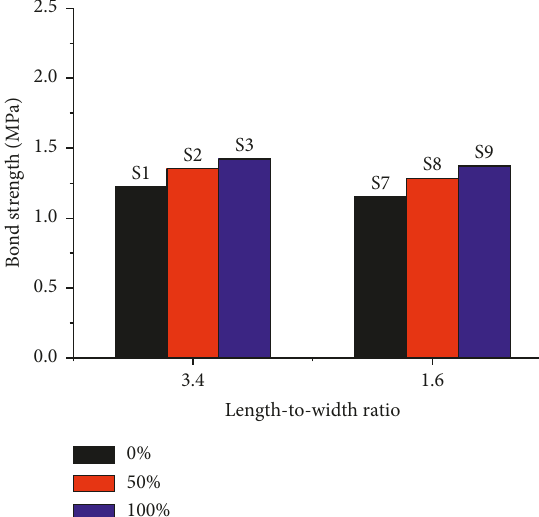
Figure 6: Effect of exposure time on bond strength.